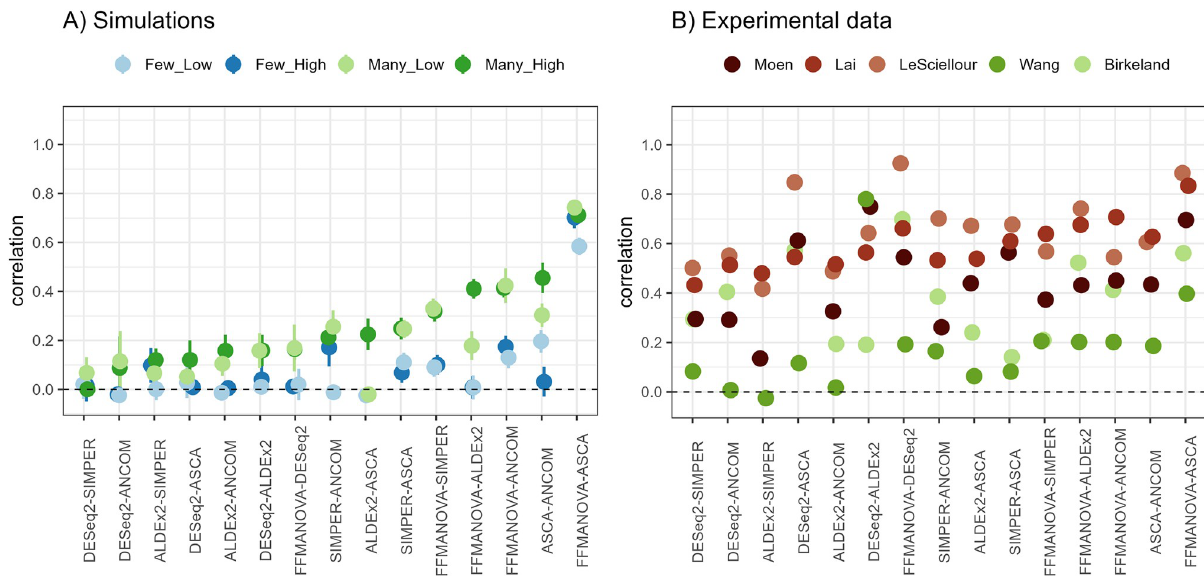
Fig 4. Spearman’s correlation (Y-axis) calculated for pairwise comparison of statistical methods (X-axis) for (A) simulated data and (B) five experimental data sets. Each point represents Spearman’s rank correlation coefficient between OTU ranking metrics from the two methods compared.